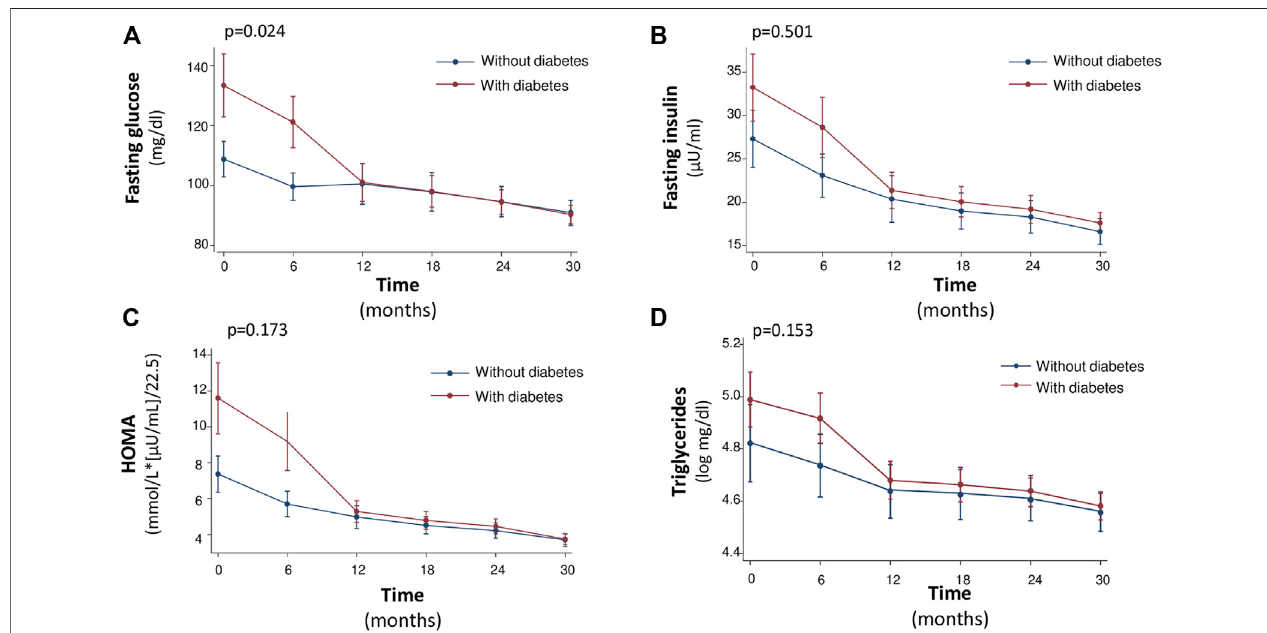
FIGURE1 | Median valuesof Fasting glucose (mg/dl) (A) ,FastingInsulin ( μ U/ml) (B) , HOMA [mmol/L*( μ U/ml)/22.5] (C) and Triglycerides (logmg/dl) (D) at baseline and every 6 months, during the 30-month follow-up.